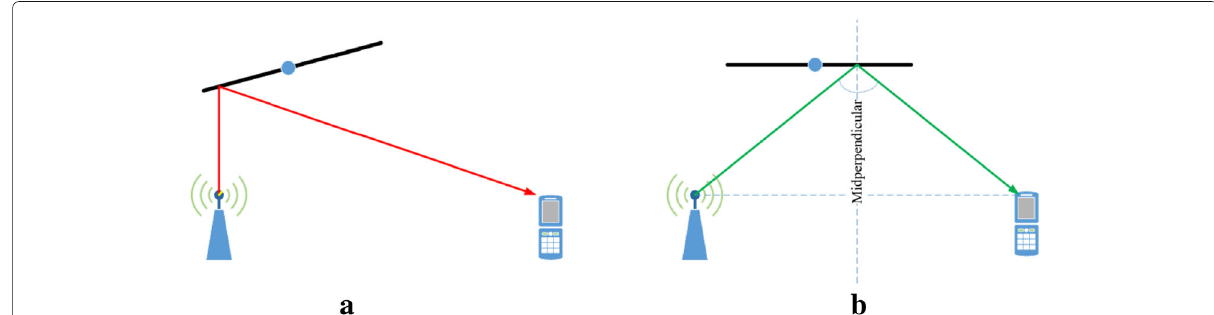
Fig. 2 Scenario I: a In the presence of reconfigurable metasurfaces, the angle of incidence and reflection are not necessarily the same. Scenario II: b According to Snell’s law of reflection, the angle of incidence and reflection are the same